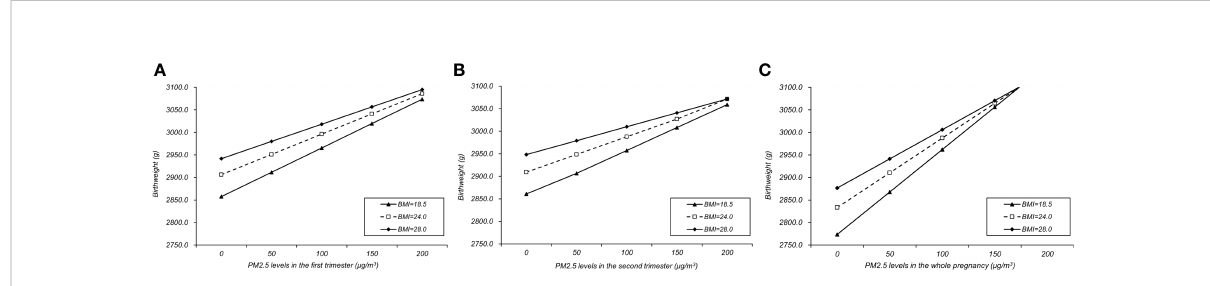
FIGURE 4 Interaction effects between PM 2.5 and pre-pregnancy BMI in the fi rst (A) , second (B) trimesters and the whole pregnancy (C)